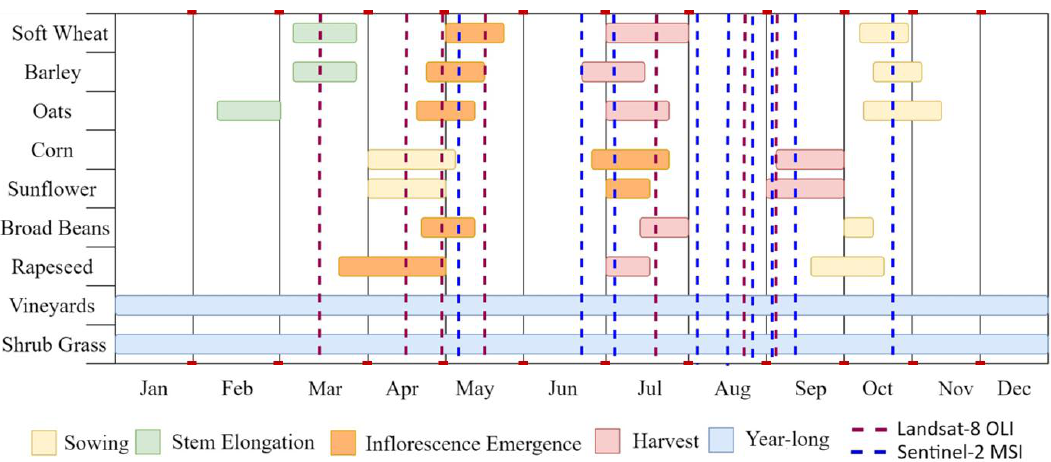
Figure 3. Timeline of phenology stages for key crops in Navarra, overlaid with the acquisition dates of Sentinel-2 images for 2016.